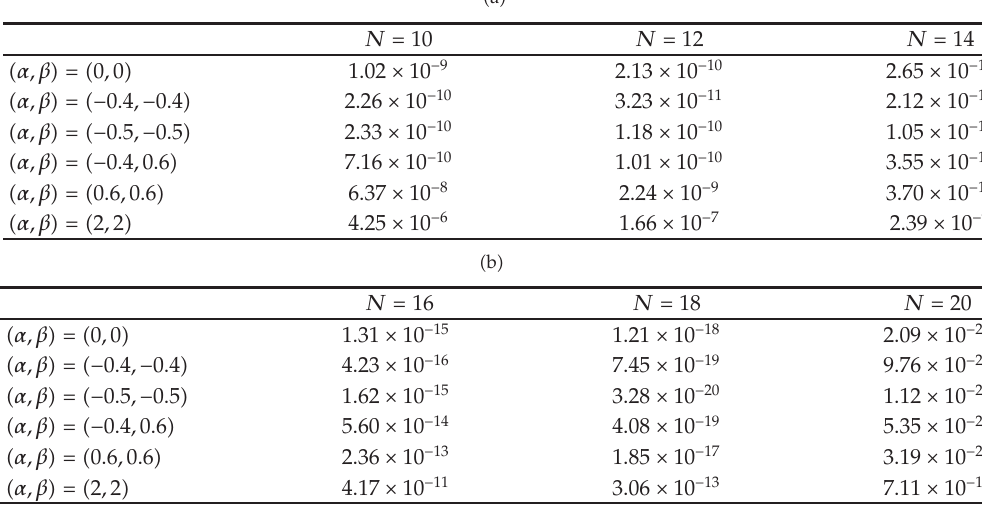
Table 3: Representation of the error by increasing the number of terms in our polynomial